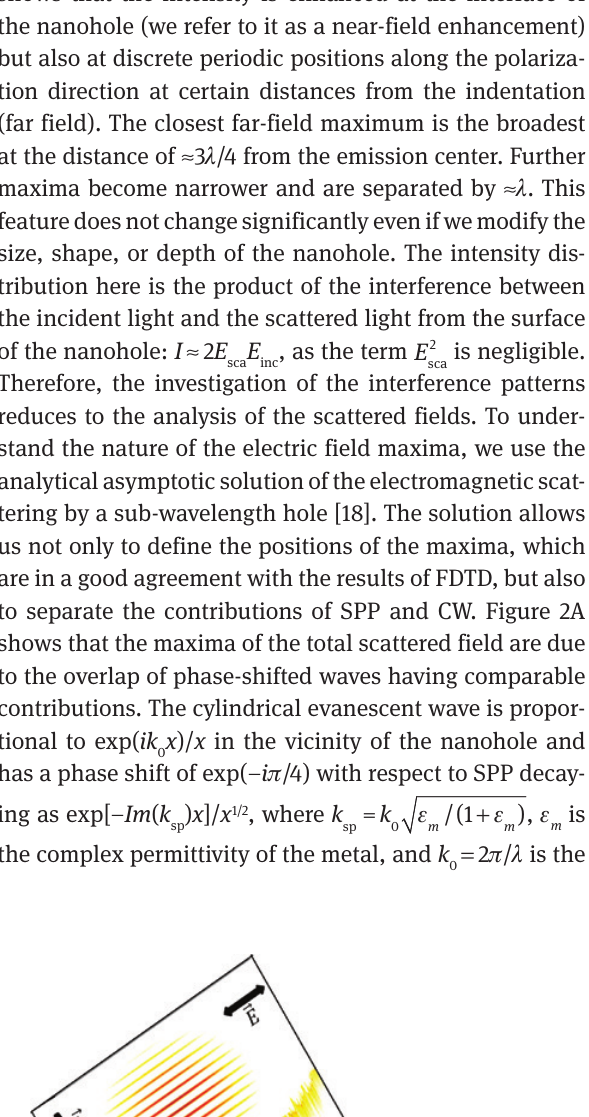
Figure 1: Geometry of the considered problem. Ultrashort laser light polarized along the X -direction falls on the metal surface with pristine or laser-induced